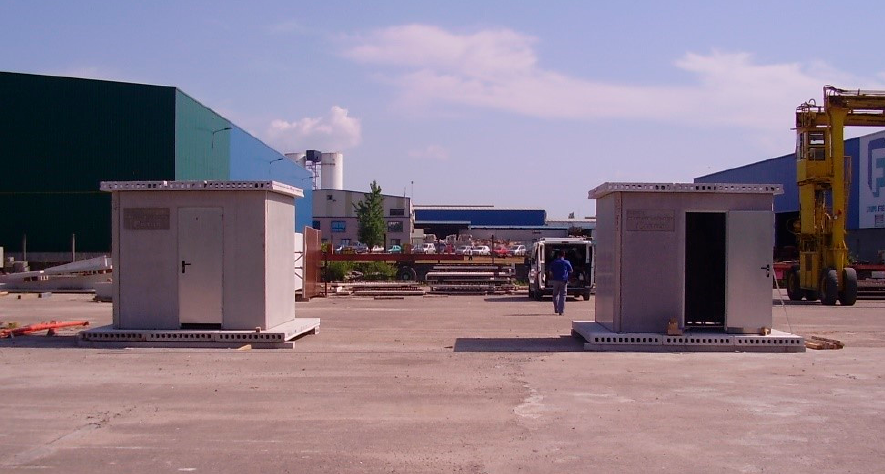
Figure 2. Experimental cubicles.